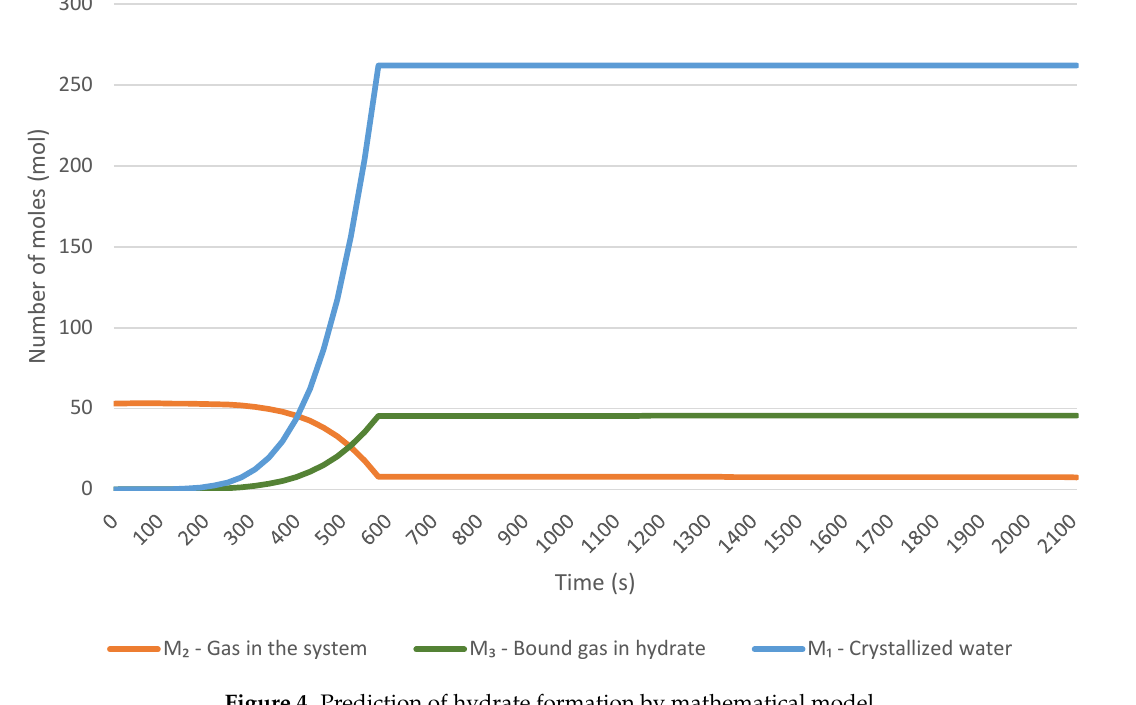
Figure 4. Prediction of hydrate formation by mathematical model.